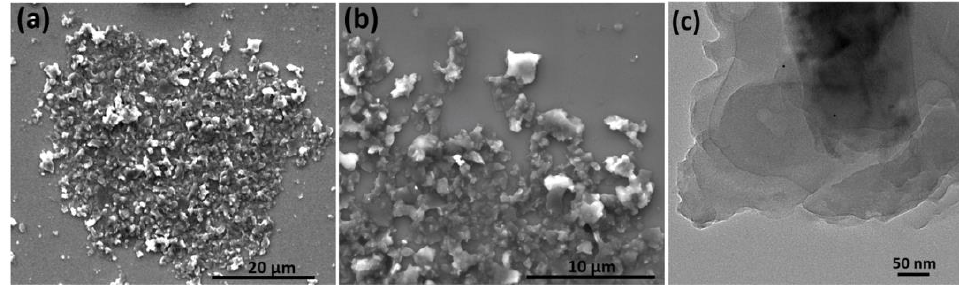
Figure 6. ( a , b ) Low and high magnification SEM images of gCN. ( c ) TEM image of layered gCN nanosheets.